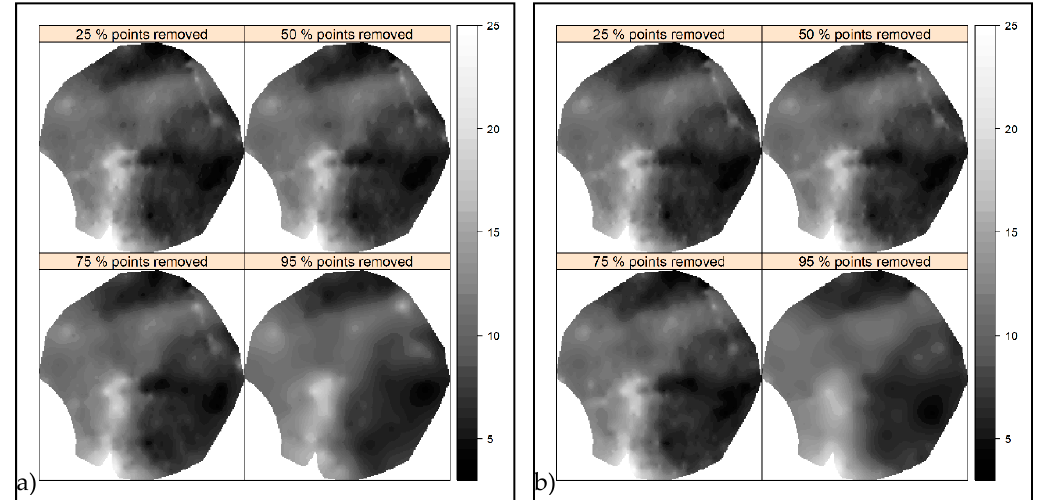
Figure 10. Soil ECa maps combining kriging interpolations of different sample density reductions (i.e., 25%, 50%, 75%, and 95%) selected by: ( a ) random algorithm; ( b ) Douglas-Peucker algorithm. Table 7. Soil ECa map accuracy results, showing ME and RMSE based on external validation for different density reductions with random selection and Douglas-Peucker algorithms.